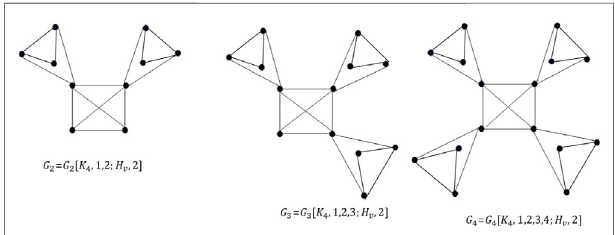
FIGURE 2 | Graphs having different numbers of